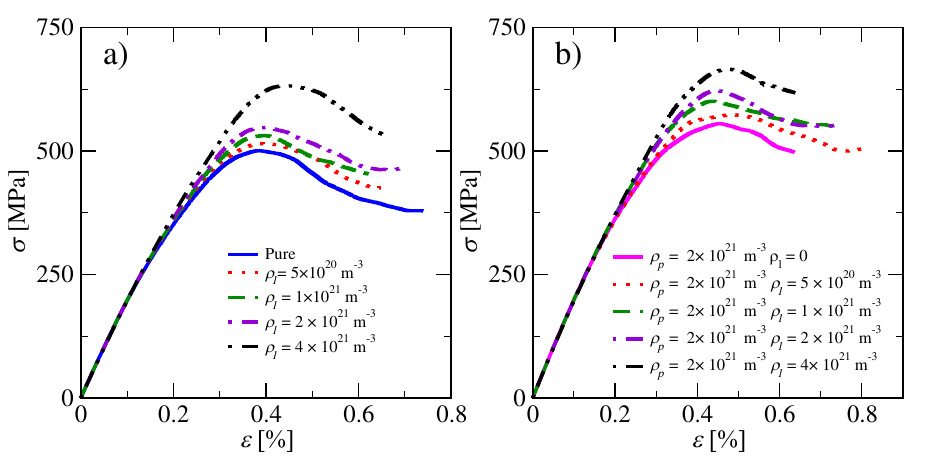
Figure 6. ( a ) Stress-strain curves of systems with only loops. Loop radius is r l = 5 nm ( b ) Stress-strain curves with a fixed precipitate density and varying loop densities. Precipitate size parameter is R p = 5 nm and the loop radius is r l = 5